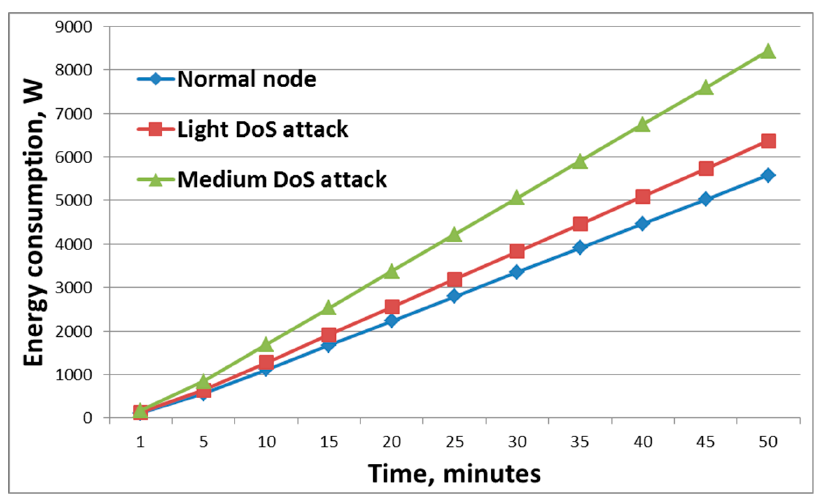
Figure 7. Energy consumption during denial of service attacks.